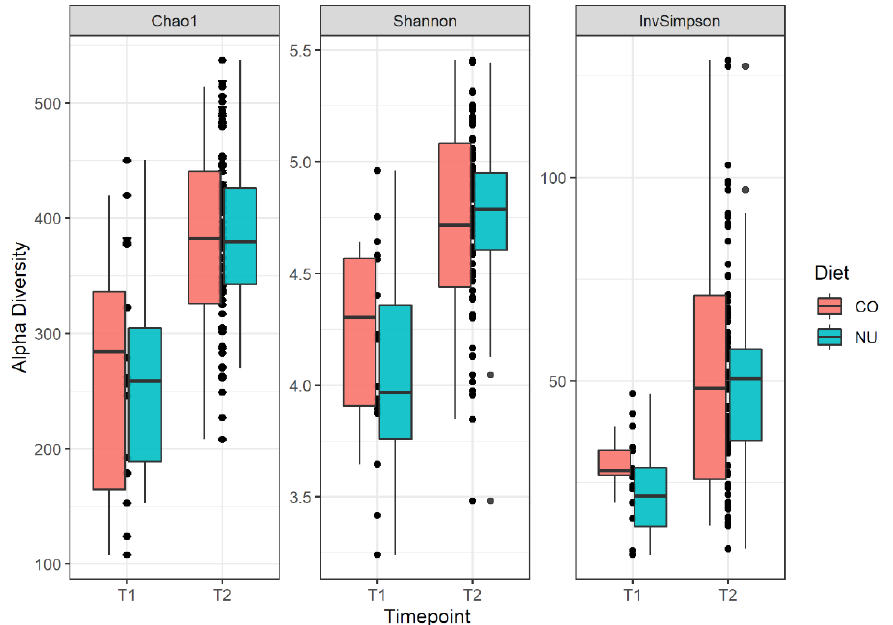
Figure 1. Alpha diversity boxplots with Chao1, Shannon and Simpson indices for the piglets divided into the 2 experimental groups (NU, CO) and the 2 sampling times (T1,T2). Simpson index, p = 0.06. results were plotted using a nonmetric multidimensional scaling plot (NMDS; Figure 2). the Adonis test (R 2 = 0.06; p = 0.01). There were no differences between the two diets at both time-points (T1 and T2).